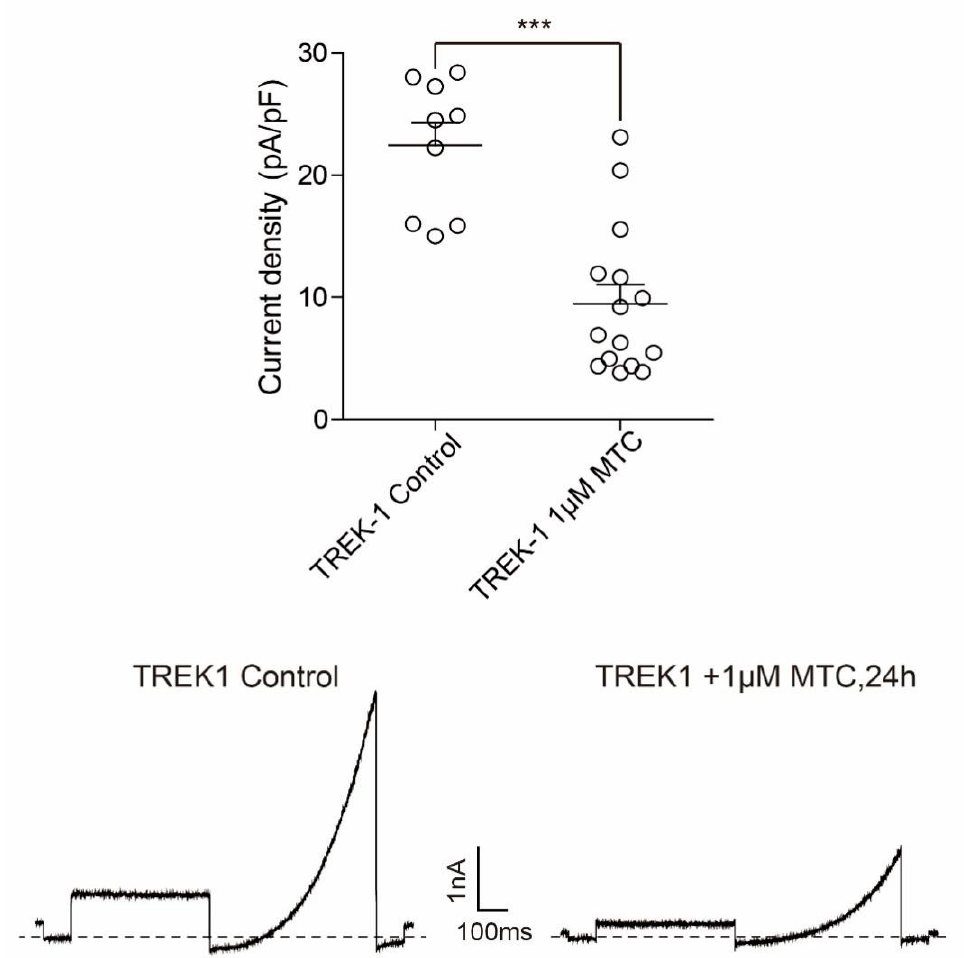
Figure 10. Effect of MTC (1 µ M) on current density of TREK1 channel, *** p <